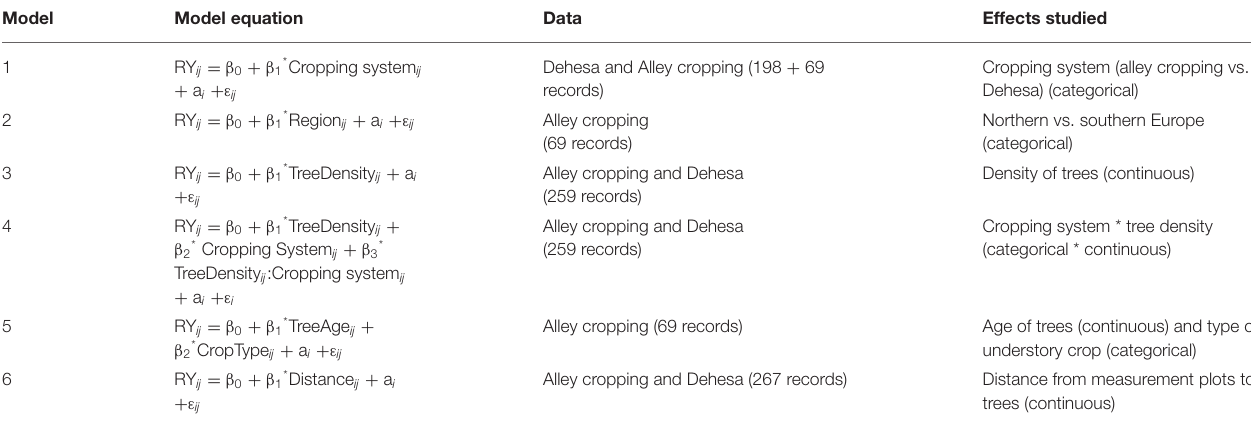
TABLE 2 | Specification of models fitted to the data. The indices i and j represent experiment ID and treatment ID within an experiment, respectively.